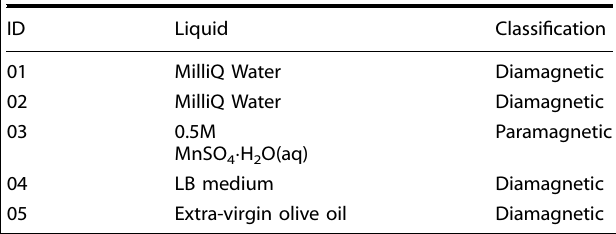
Table 1. Liquids employed on each drop experiment.